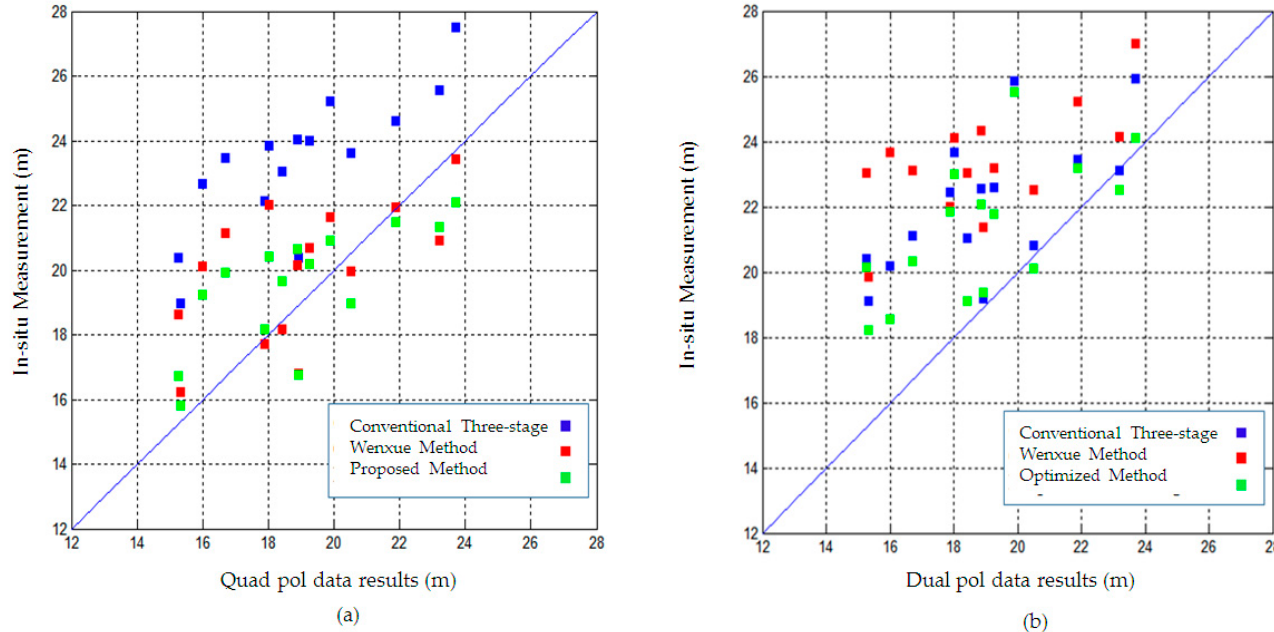
Figure 10. Comparison between LiDAR measurement (vertical axis) and forest height estimation based on the conventional, Wenxue method, and ESPO method (horizontal axis) using ( a ) quad pol images and ( b ) dual pol images.